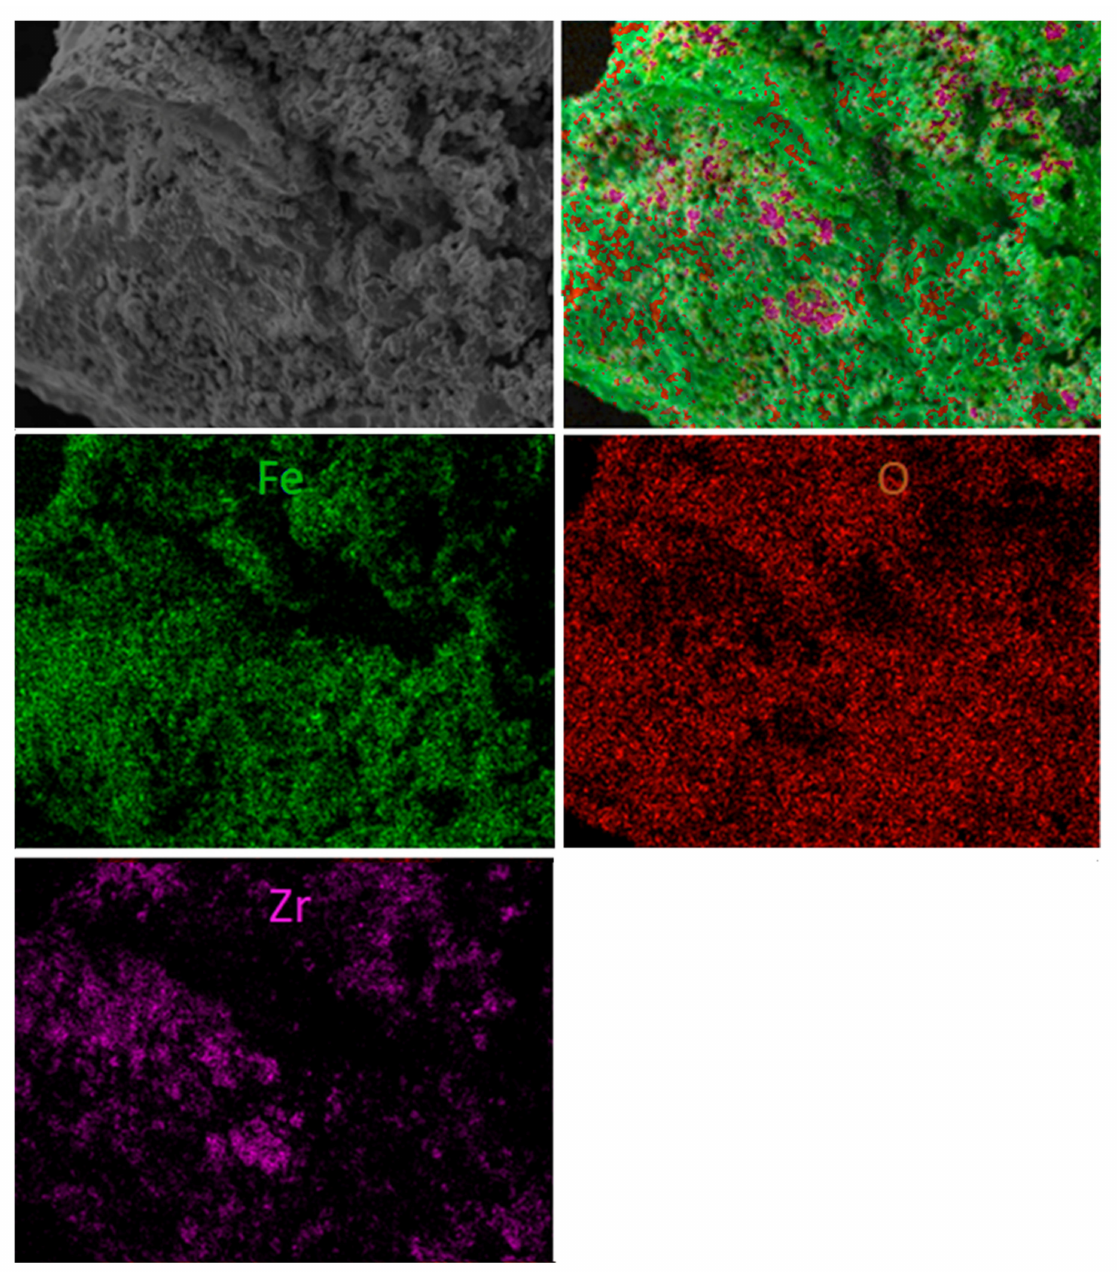
Figure 12. Scanning electron microscope photomicrographs with element mapping for reacted and regenerated F80